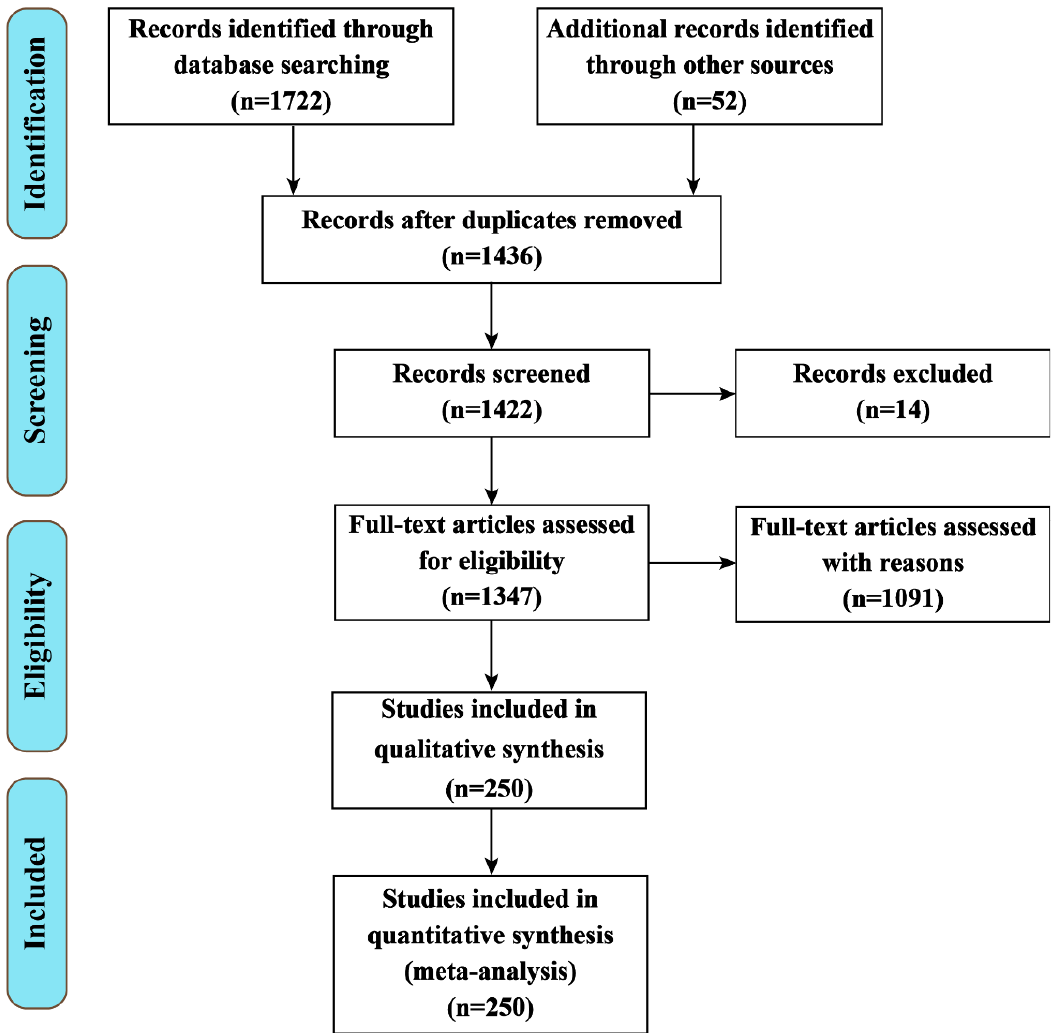
Figure 1. PRISMA 2009 Flow Diagram for the review detailing the database searches, the number of abstracts screened and the full texts retrieved.